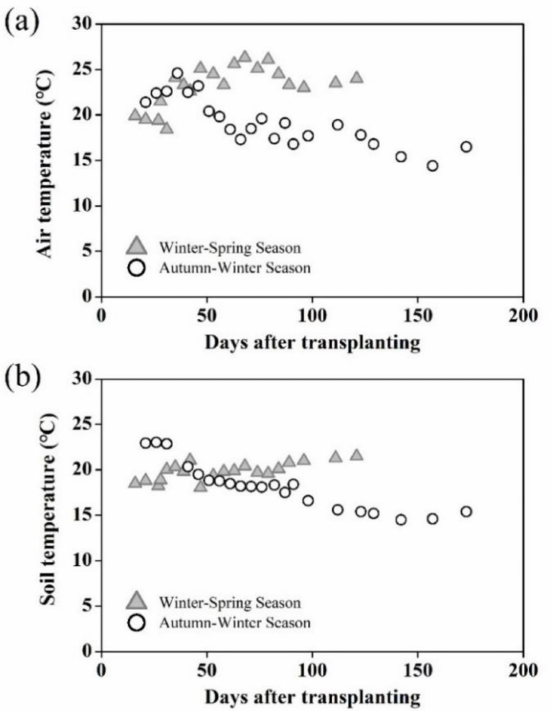
Figure 1. Air temperature at 1 m above the ground measured at 8:30–10:00 a.m. in tomato greenhouse